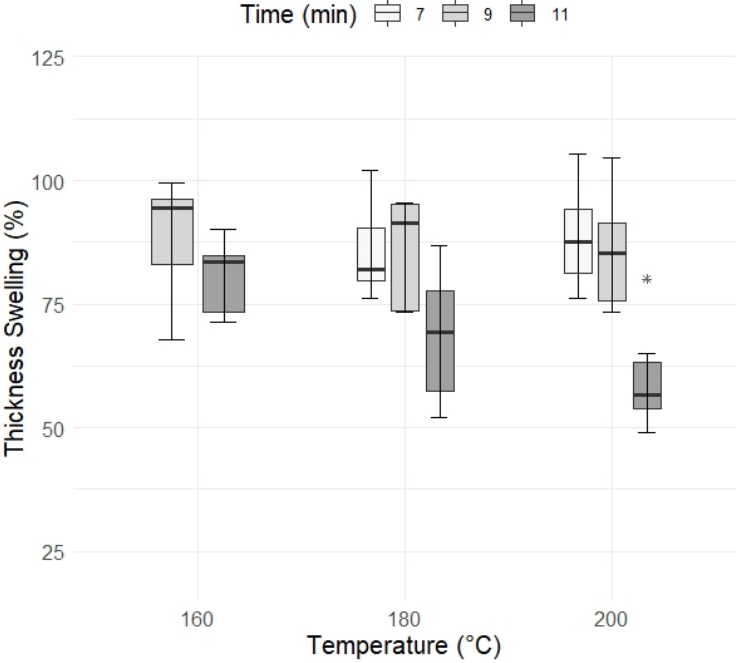
Figure 6. Thickness swelling after 24 h of the produced particleboards in function of the pressing parameters. * p <